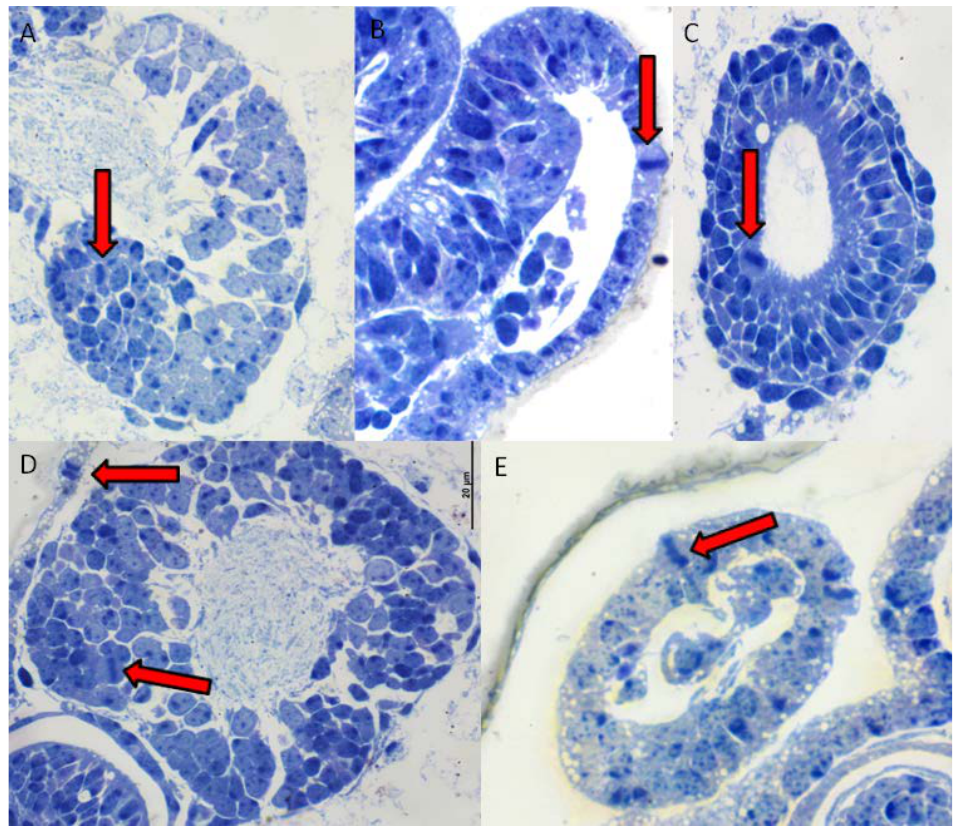
Figure 3. The mitotic cells divisions (pointed by the arrows) in C. cupressi aphid’s body: ( A ) nervous system, ( B ) body, ( C ) body, ( D ) nervous system, ( E ) leg. All scale bars are 20 µm long.